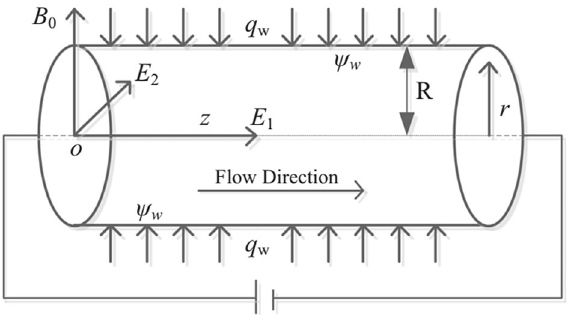
Figure 1. Diagram of flow model.